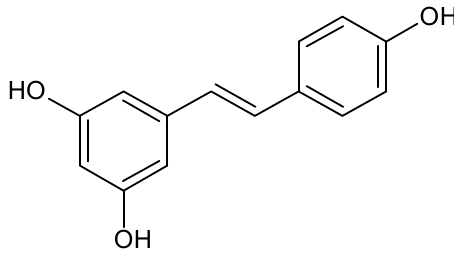
Figure 7. Chemical structure of resveratrol.